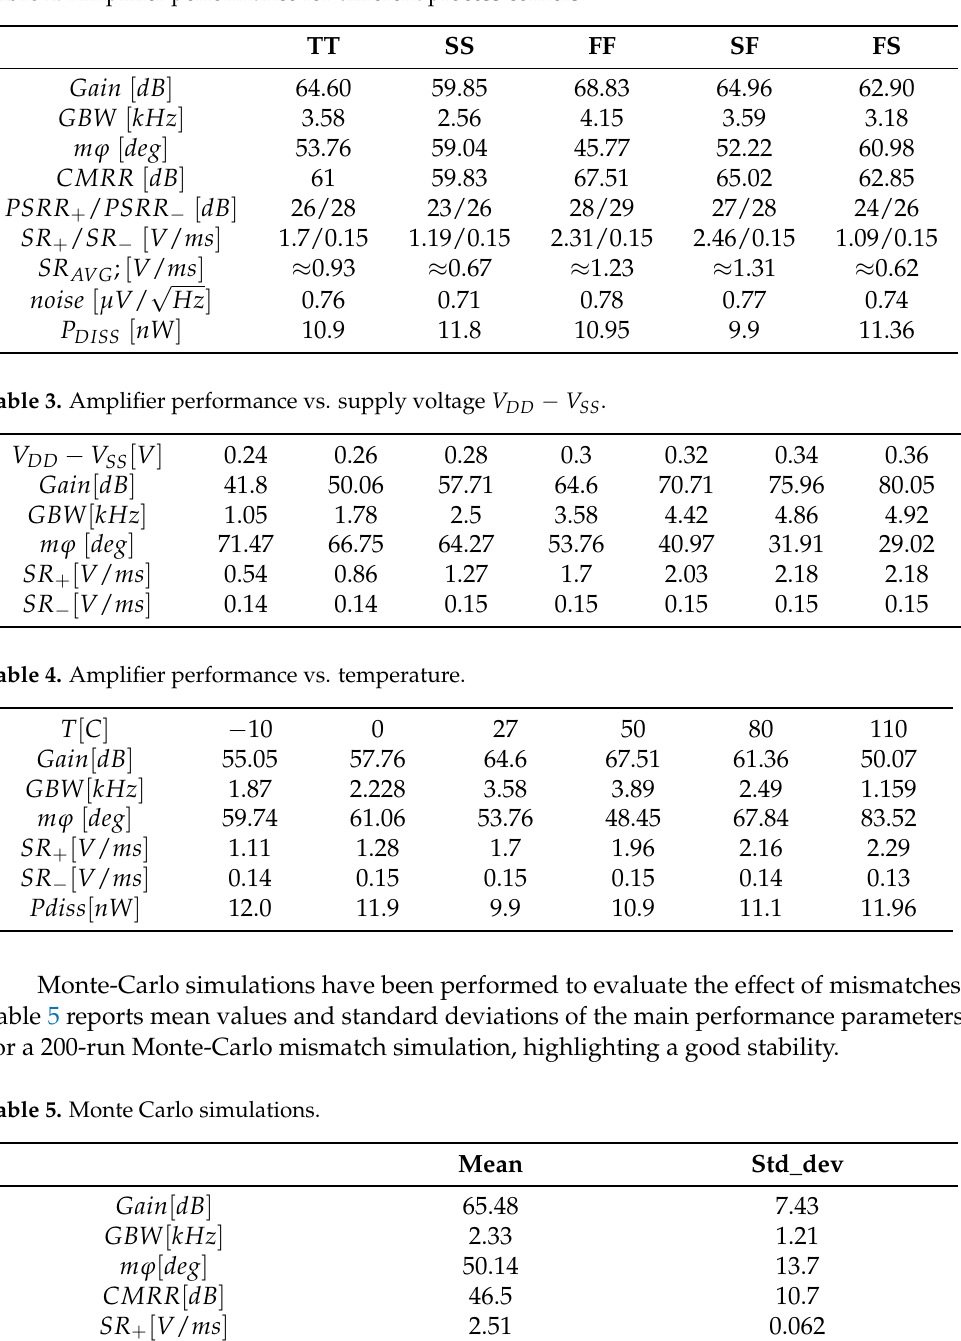
Table 2. Amplifier performance for different process corners.